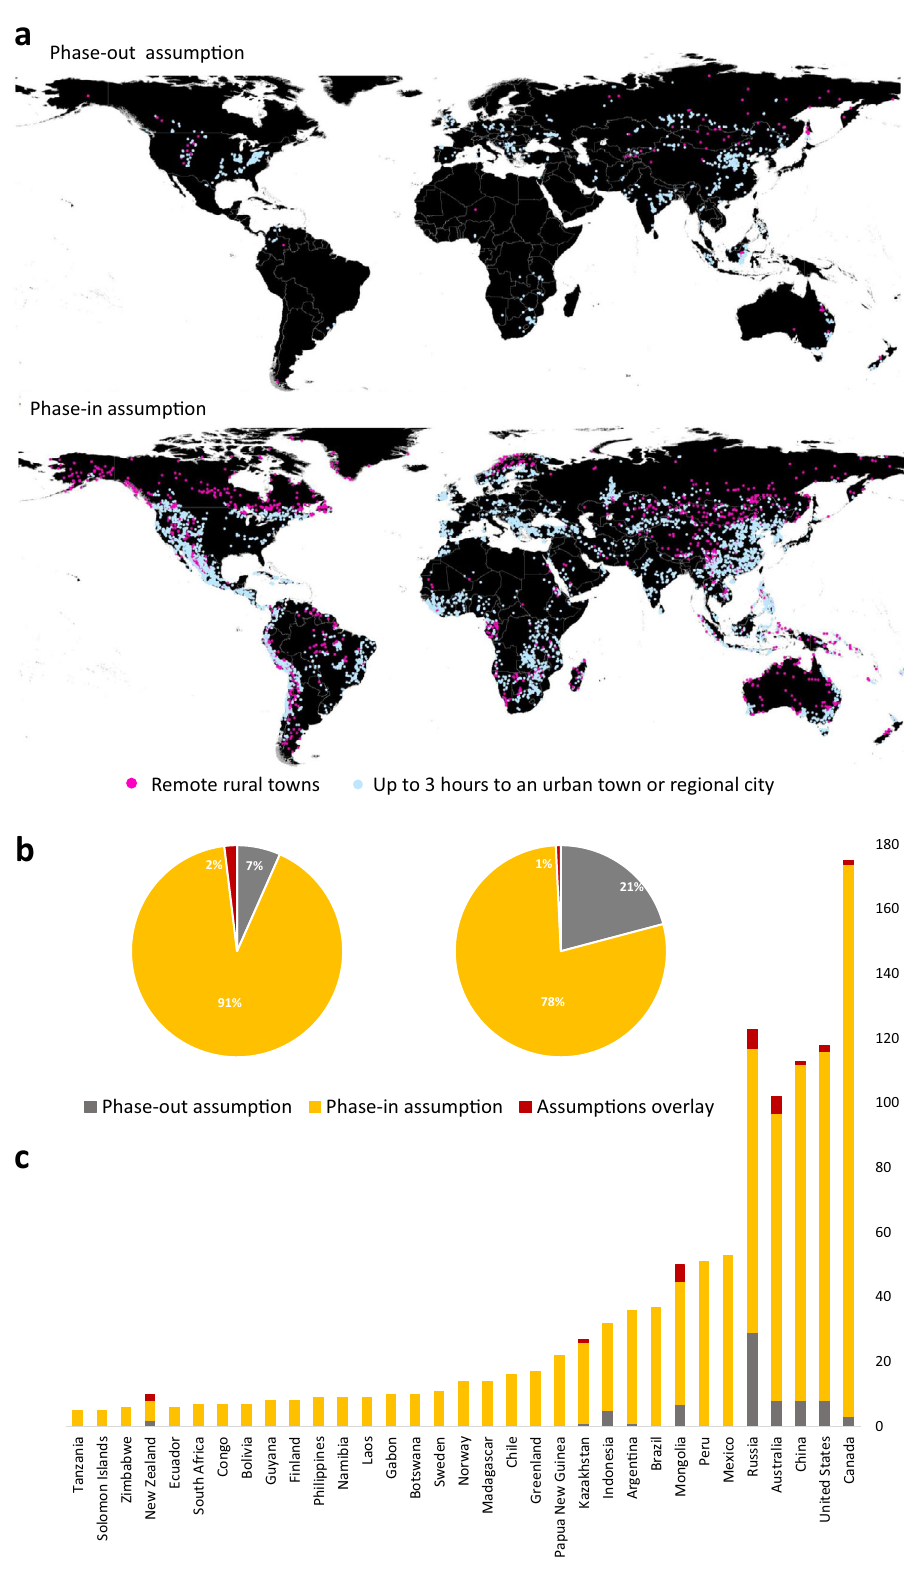
Fig. 6 | The impact of phase-out and phase-in assumptions on remote rural towns and mine-town systems. a Geography of the remote rural towns (in pink) and rural towns reachable in up to 3h (in blue), which are part of the global mine- townsystemsimpactedbycoalphase-outandETMphase-inassumptionscarriedin